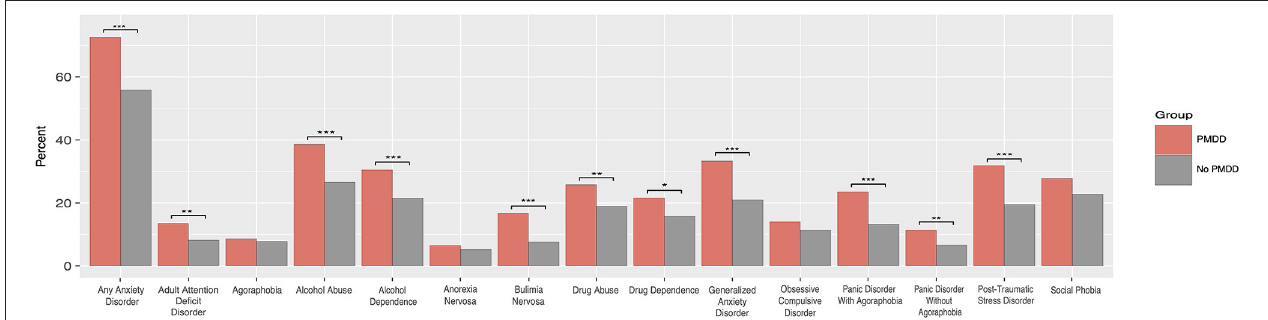
FIGURE 1 | Psychiatric comorbidities in women with bipolar disorder with and without comorbid premenstrual dysphoric disorder. *** p < 0.001; ** p < 0.01, * p < 0.05. PMDD, Premenstrual Dysphoric Disorder; OCD, Obsessive Compulsive Disorder. Reproduced with permission from Slyepchenko et al.